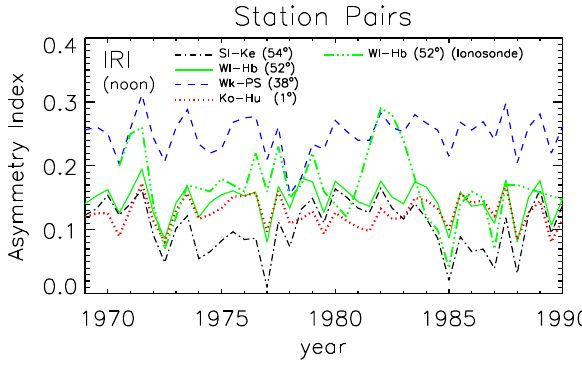
Fig. 4. Variation of the annual asymmetry in peak electron density at noon for four station pairs over two solar cycles, computed from the International Reference